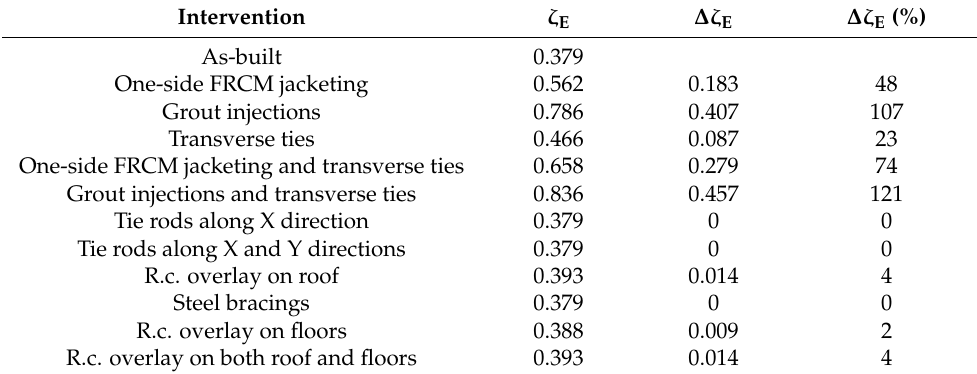
Table 5. Performance ratios ζ E for single-unit model in as-built and strengthened conditions at SD limit